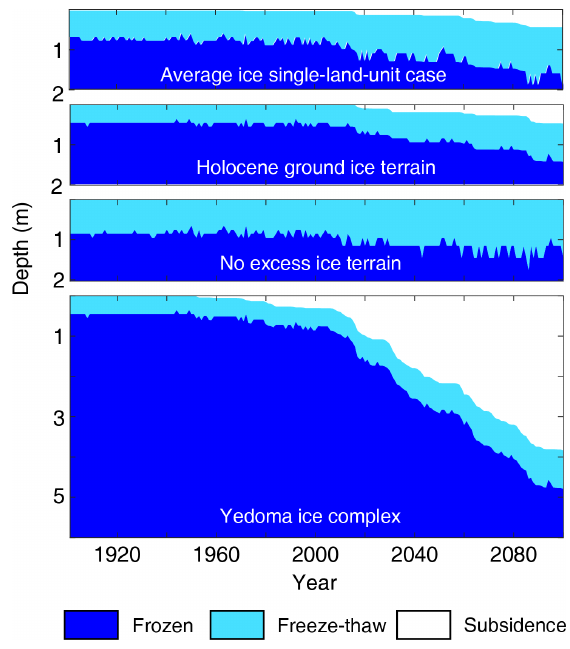
Figure 4. Annual freeze–thaw state for the three terraces for the triple-land-unit case, as well as for the average-ice single-land-unit